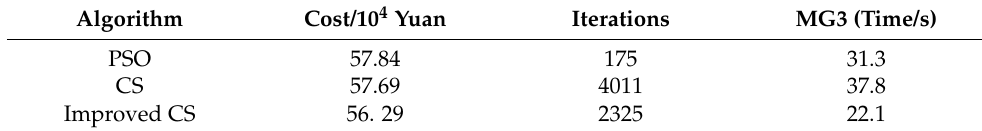
Table 7. Improved algorithm.